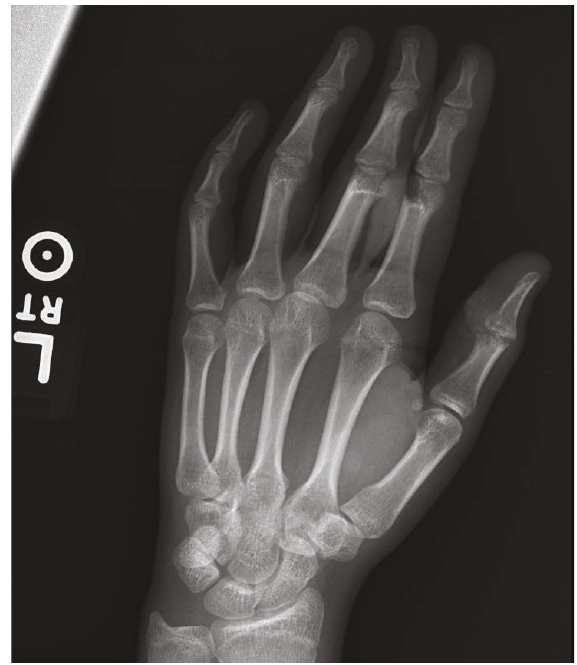
Figure 1: Preoperative AP view of the thumb.